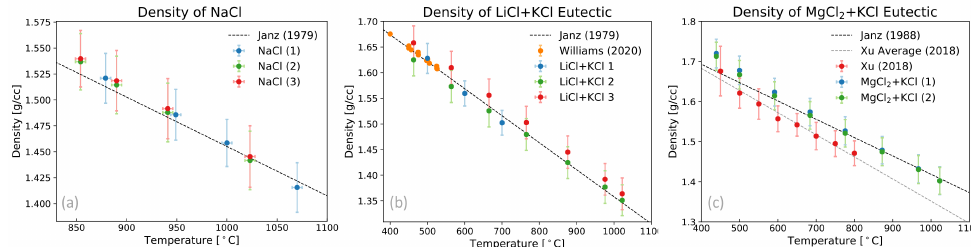
Figure 4. Density measurements via neutron radiography from this work as a function of temperature, along with selected previous works, for ( a ) NaCl, ( b ) LiCl + KCl eutectic, and ( c ) MgCl 2 + KCl eutectic